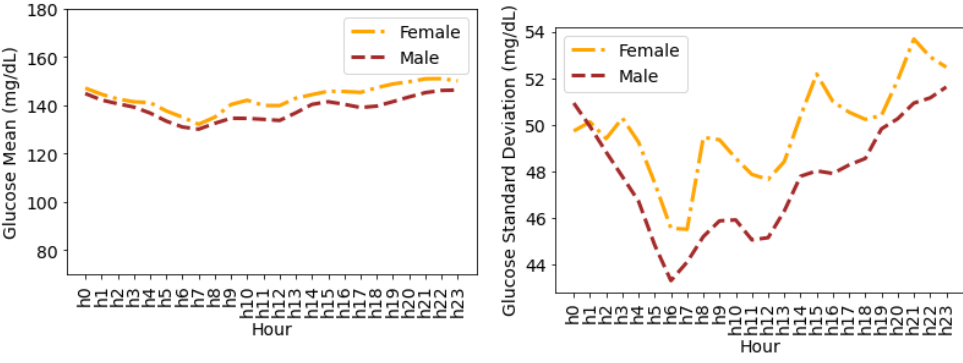
Figure 7. Average glucose mean and standard deviation for insulin-requiring individuals in OpenAPS Data Commons dataset during hours of a day based on gender. Total number of males and females is 50 and 28,